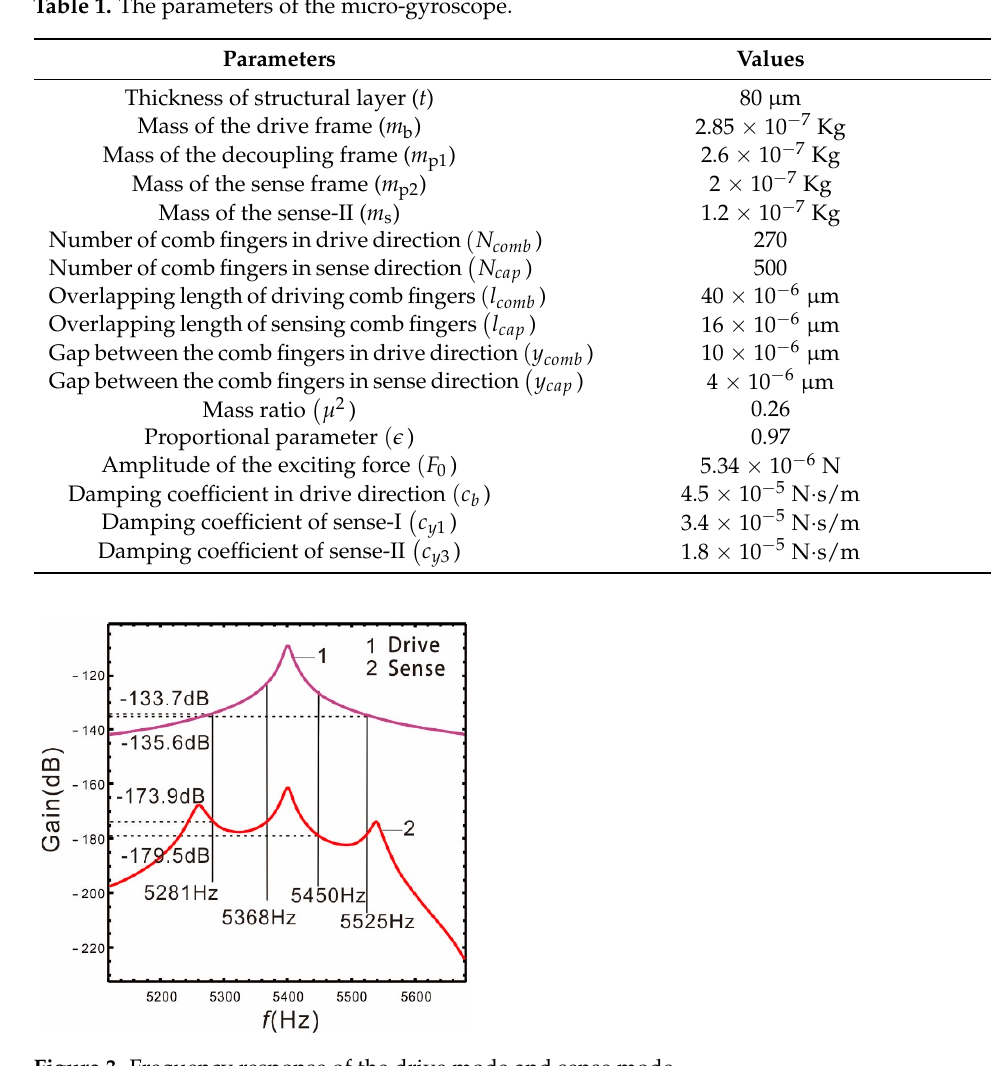
Figure 3. Frequency response of the drive mode and sense mode.